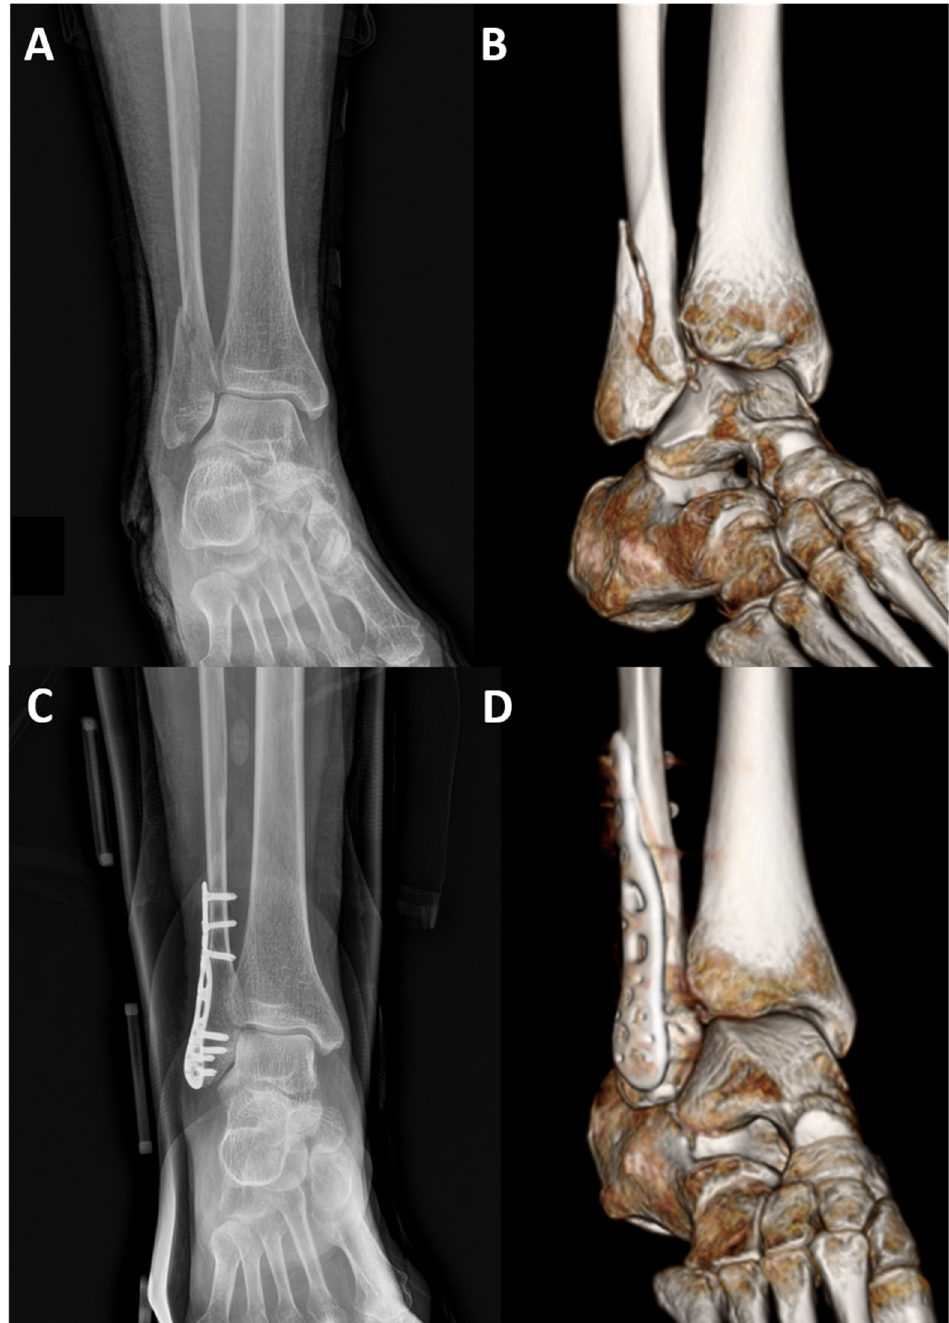
Figure 5. Preoperative radiograph ( A ) and CT ( B ) images of an isolated Weber B type fracture. Postoperative radiograph ( C ) and CT ( D ) images showing the fracture treated with a three-dimensionally pre-contoured locking plate that is properly fit on the bone. Table 1. Functional and radiographic rating according to McLennan and Ungersma’s criteria (compared to the normal ankle).